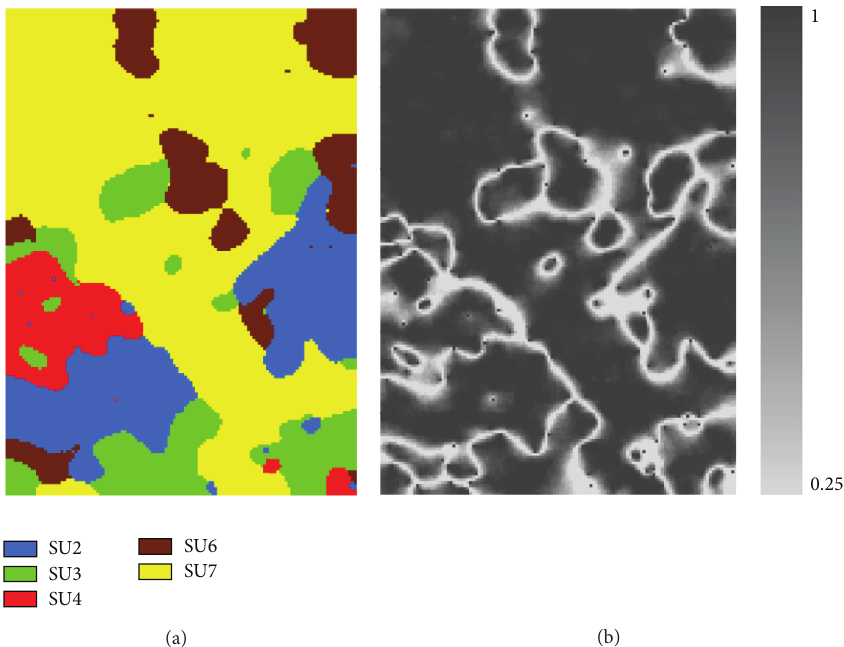
Figure 8: The optimal prediction map (a) and the maximum occurrence probability map (b) of updated soil series conditioned only on the sample data using the MCSS method.